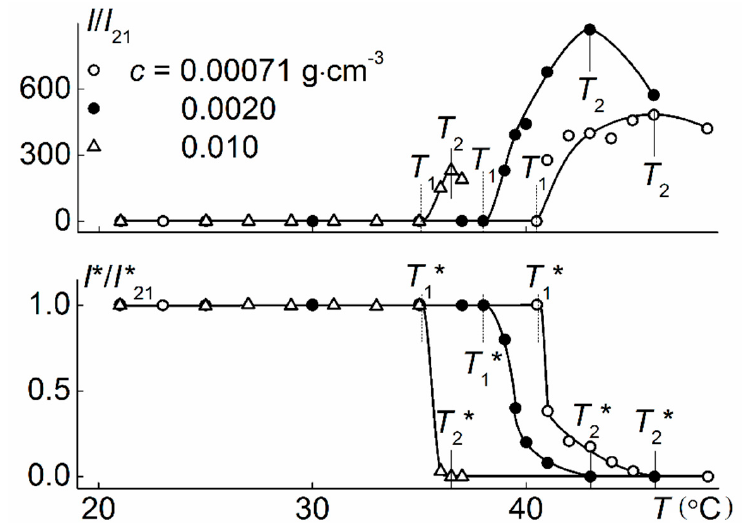
Figure 8. The temperature dependences of relative light scattering intensity I / I 21 and relative transmittance I * / I * 21 for aqueous solutions of PiPrOx-m. I 21 and I * 21 are intensities of light scattering and optical transmittance at T = 21 °C, respectively.